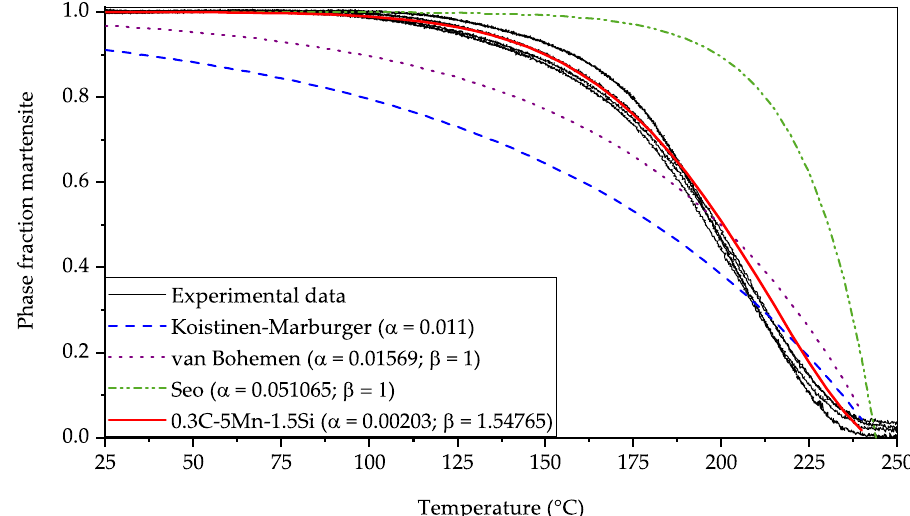
Figure 5. Experimental and empirical determination of primary martensite’s phase fraction in dependence of T Q